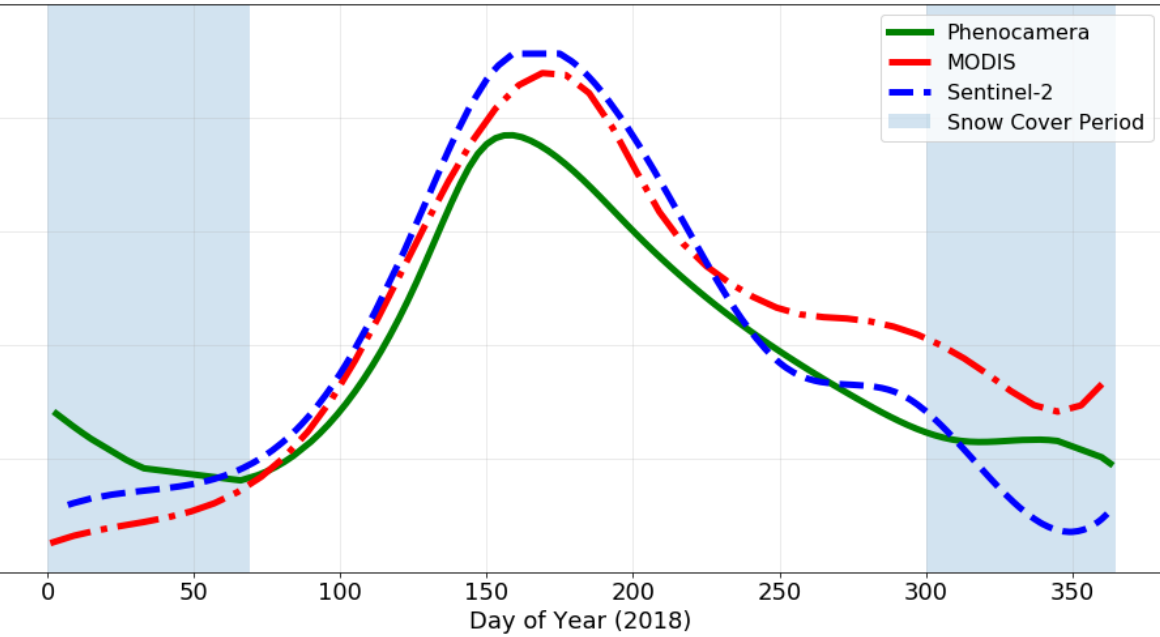
Figure 11. GCC values are presented to compare seasonal trends derived from PhenoCam GCC (green), MODIS GCC (red), and Sentinel-2 GCC (blue) sensors. The y axis is a normalized scale from indices’ minimum to maximum values (to make it easy for effective visualization and comparison with other VI profiles).